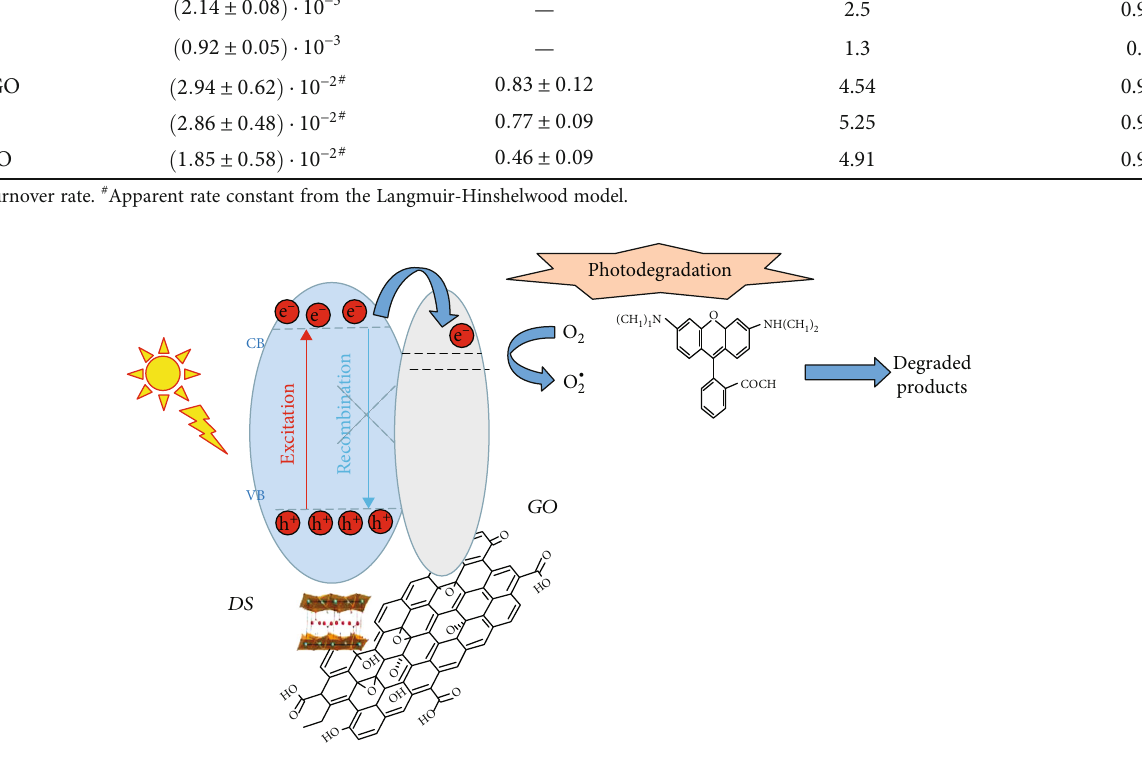
Figure 5: Schematic illustration of band levels and charge transfer in GO-DS